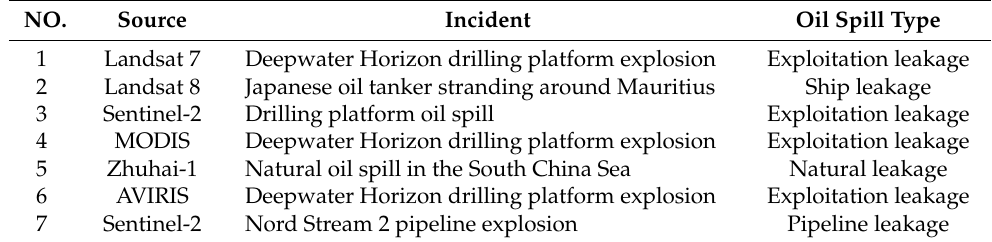
Table 2. The information of the experimental datasets.